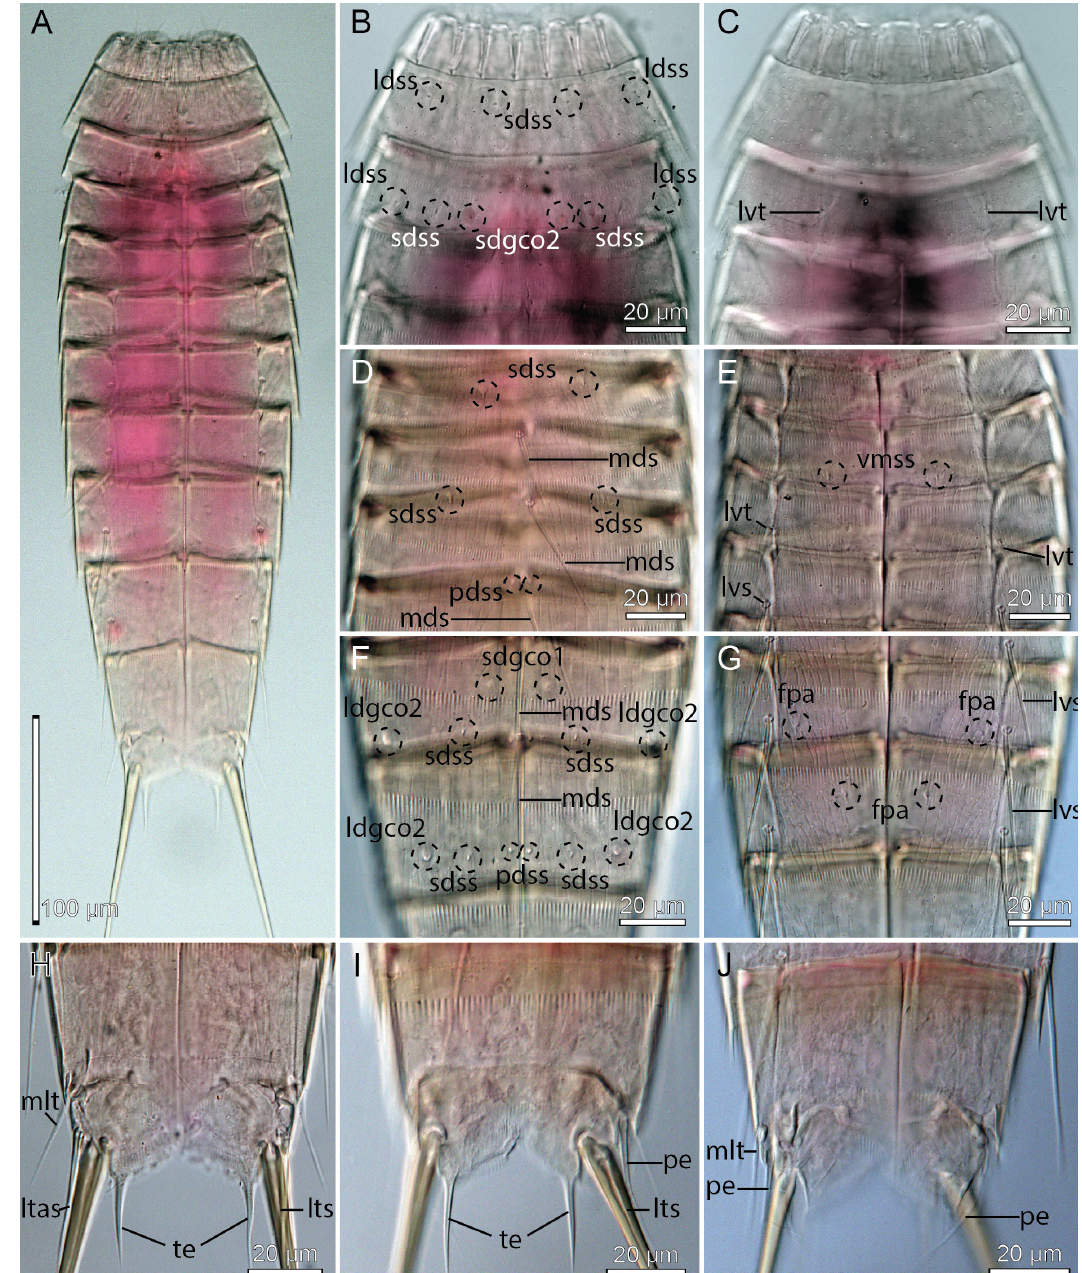
Fig. 19. Light micrographs showing overviews and details of Echinoderes lupherorum sp. nov., holotype, ♀ (A–C, H) (NHMD-225220), paratype, ♀ (D–G) (NHMD-225226) and paratype, ♂ (I–J) (NHMD-225225). A . Ventral overview. B . Segments 1 to 3, dorsal view. C . Segments 1 to 3, ventral view. D . Segments 3 to 6, dorsal view. E . Segments 3 to 6, ventral view. F . Segments 8 to 9, dorsal view. G . Segments 7 to 8, ventral view. H . ♀, segments 10 to 11, ventral view. I . ♂, segments 10 to 11, dorsal view. J . ♂, segments 10 to 11, ventral view. Abbreviations: fpa = female papillae; ldgco2 = laterodorsal glandular cell outlet type 2; ldss = laterodorsal sensory spot; ltas = lateral terminal accessory spine; lts = lateral terminal spine; lvs = lateroventral spine; lvt = lateroventral tube; mds = middorsal spine; mlt = midlateral tube; pdss = paradorsal sensory spot; pe = penile spine; sdgco1/2 = subdorsal glandular cell outlet type 1 or 2; sdss = subdorsal sensory spot; te = tergal extensions; vmss = ventromedial sensory